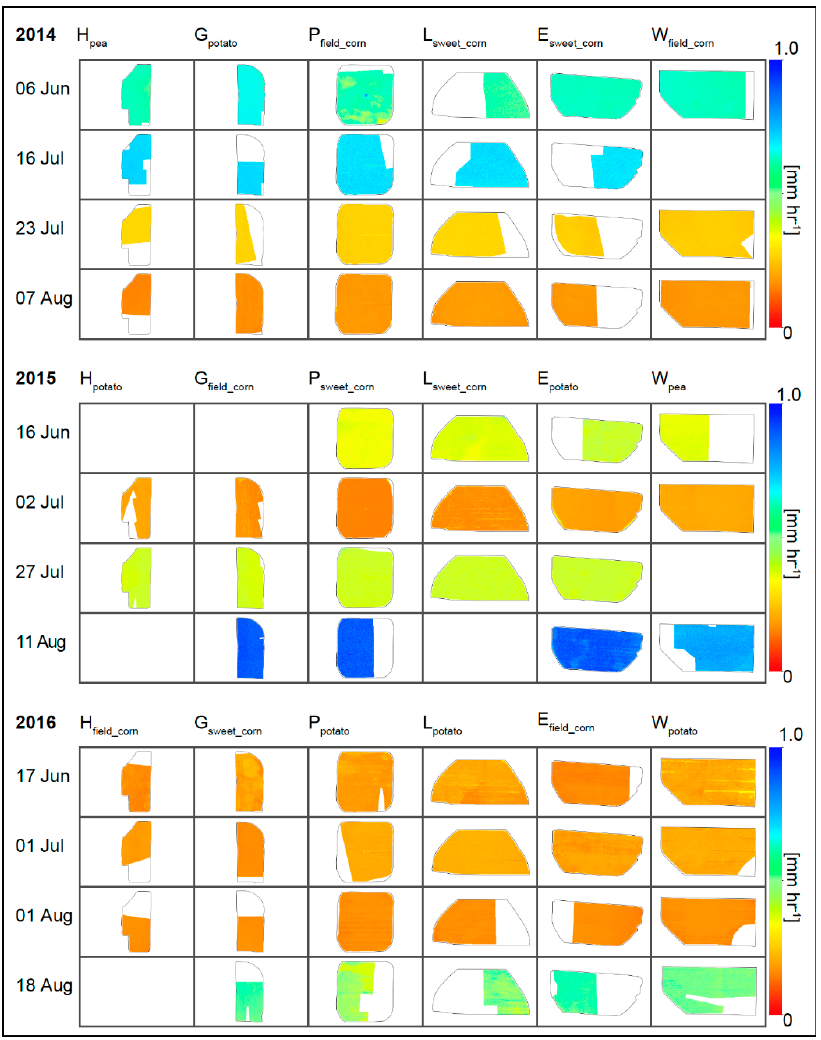
Figure 7. Standard deviation of HRMET-calculated ET rates (mm hr − 1 ) for fields H, G, P, L, E, and W for 12 airborne missions in 2014–2016. All maps are linearly scaled to the same color bar. Blank spaces indicate missing imagery because of cloud interference during missions.